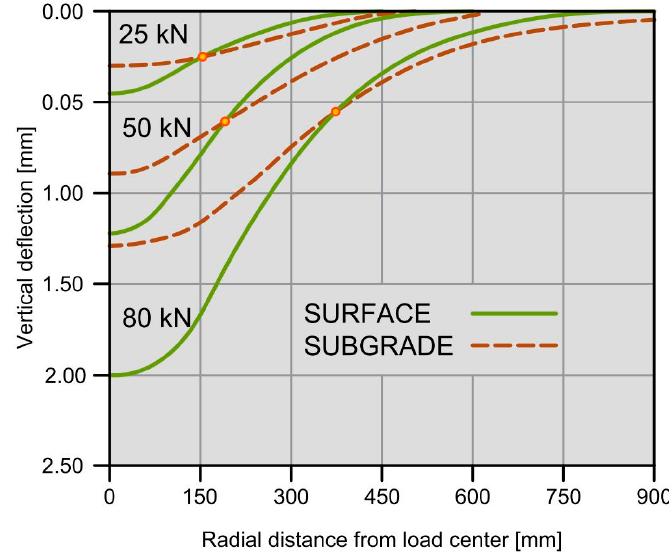
Figure 5. Subgrade and surface vertical deflection profiles with various axle loads [14].